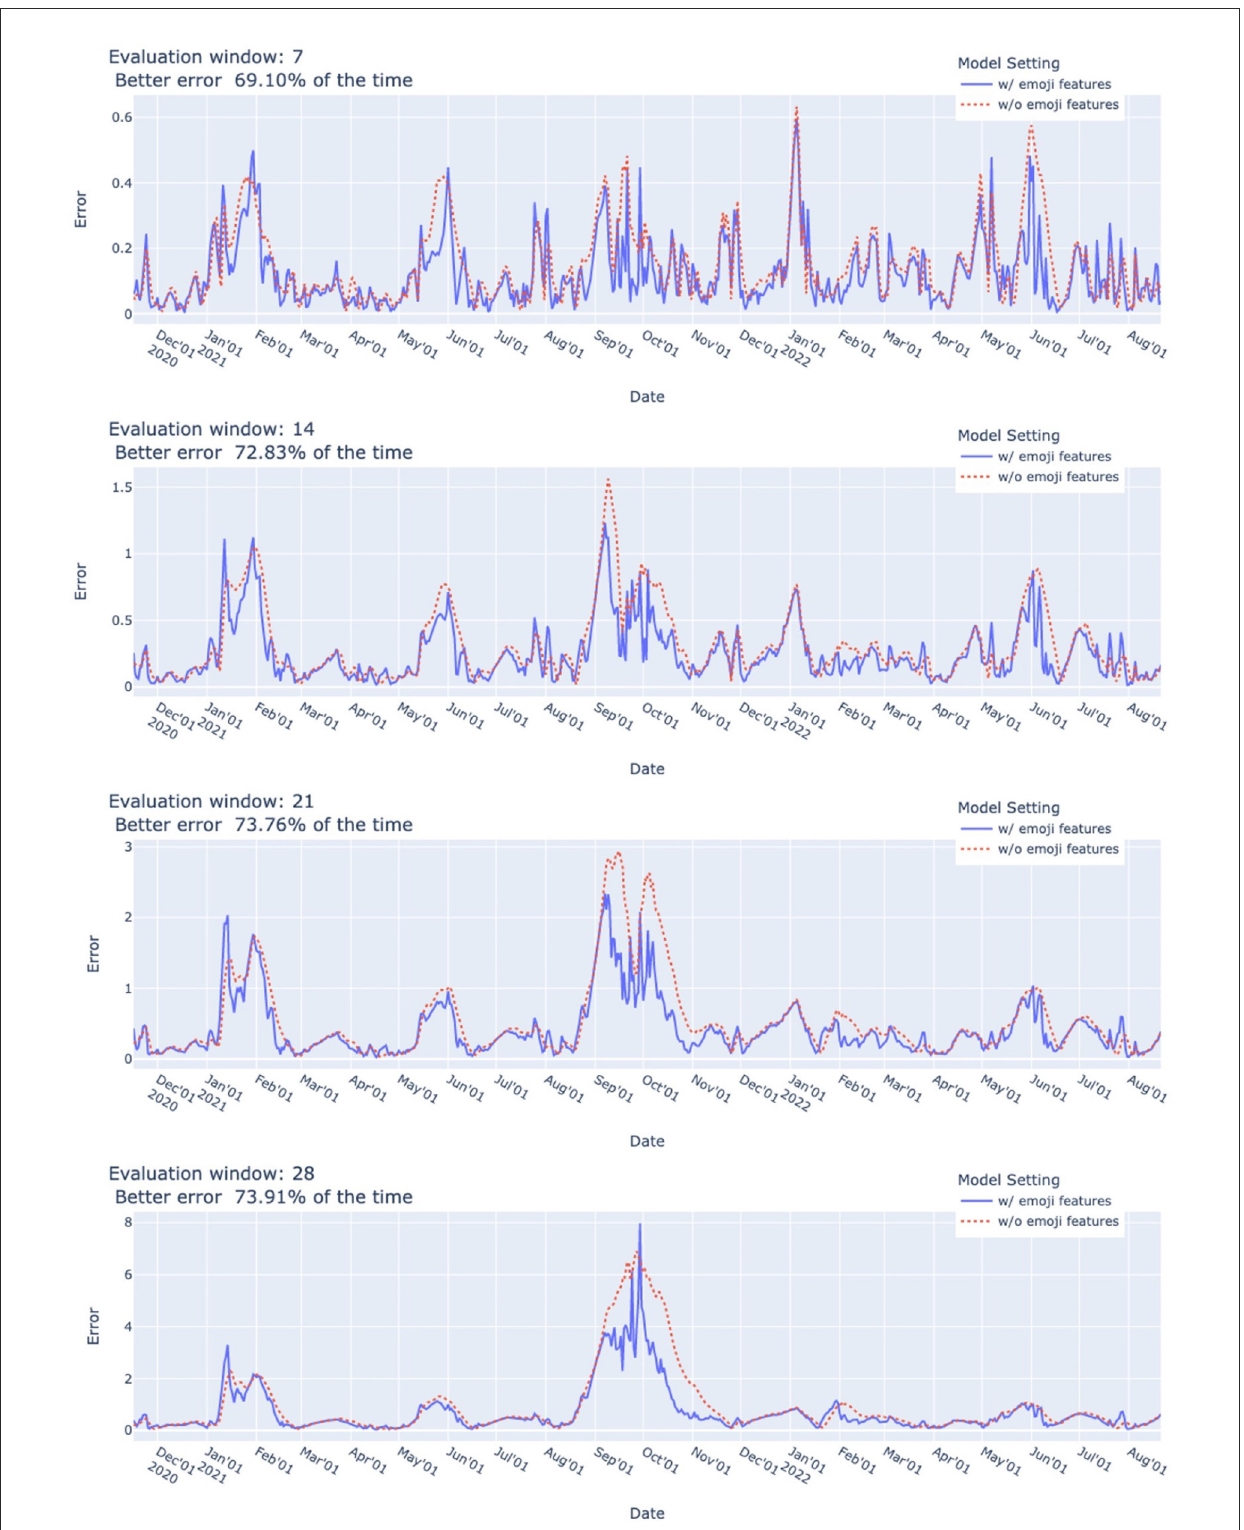
FIGURE6 COVID-19 case prediction system performance (MRAE). Error at given date was measured on basis of prediction for evaluation window starting from given date from 2020/11/16 to 2022/08/21. Using additional emoji features yielded better error 69.10–73.91% of the time. Relative error reduction ranged from 0.10 to 94.14% with mean of 28.77% and median of 23.91%. Dynamic ensemble parameters : τ 1 = 1, τ 2 = 7, m = 10, ˆ δ =